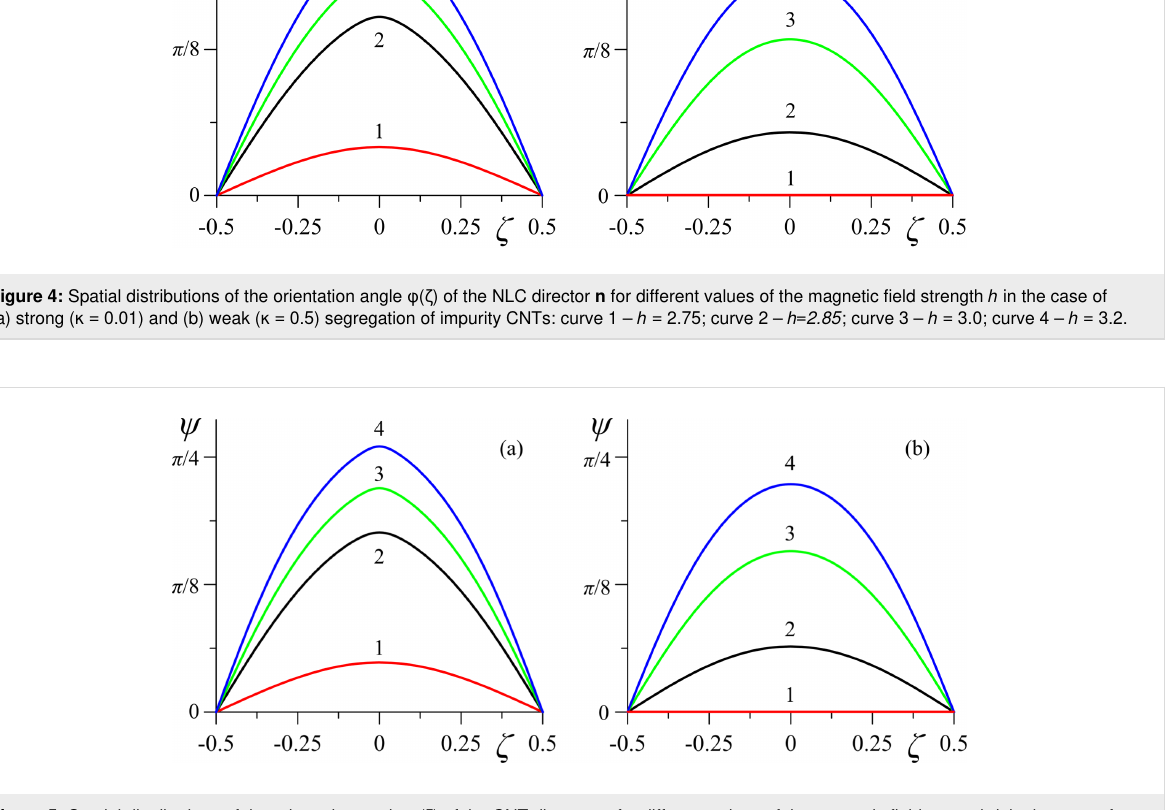
Figure 5: Spatial distributions of the orientation angle ψ ( ζ ) of the CNT director m for different values of the magnetic field strength h in the case of (a) strong ( κ = 0.01) and (b) weak ( κ = 0.5) segregation of impurity CNTs: curve 1 – h = 2.75; curve 2 – h = 2.85; curve 3 – h = 3.0; curve 4 – h = 3.2.